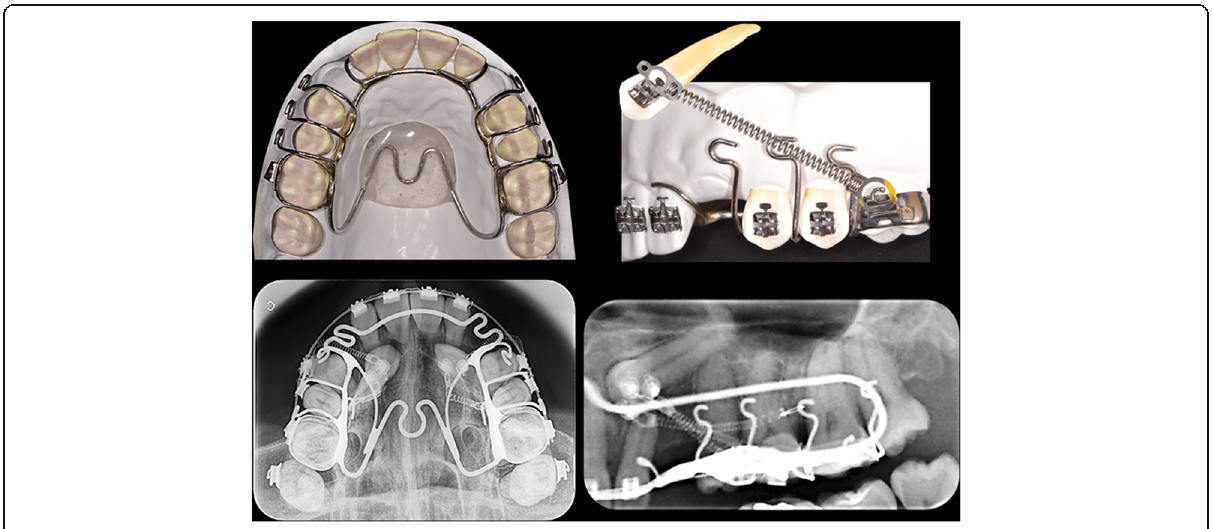
Fig. 4 Graphic design and radiographic images of canine traction method